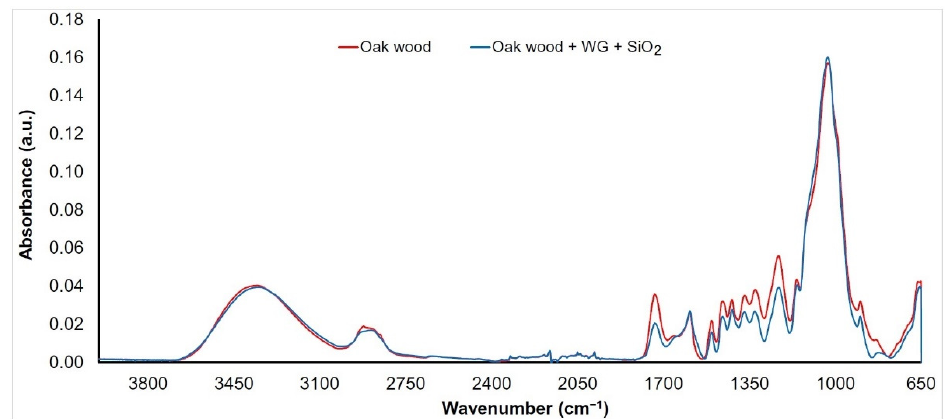
Figure 4. FTIR spectrum of oak wood coated with water glass and SiO 2 nanoparticles.